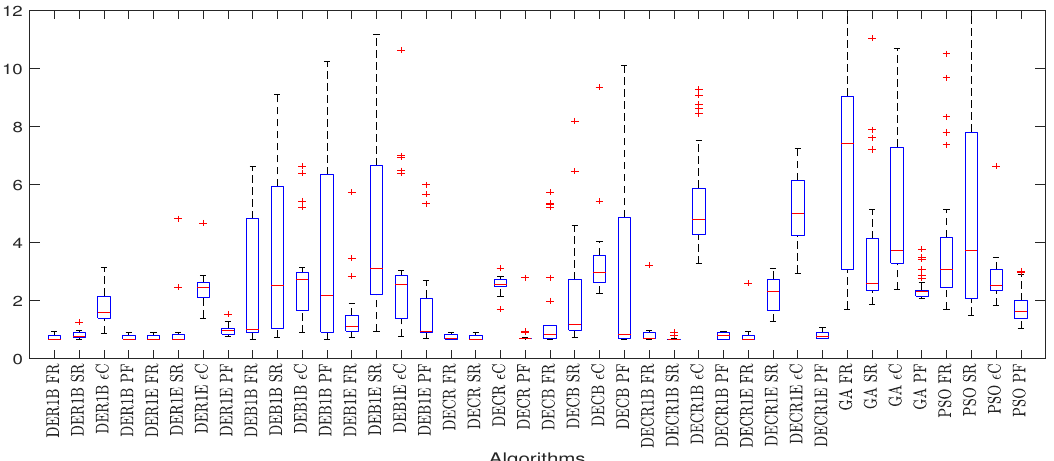
( a ) Study case 1: Four-bar linkage mechanism.